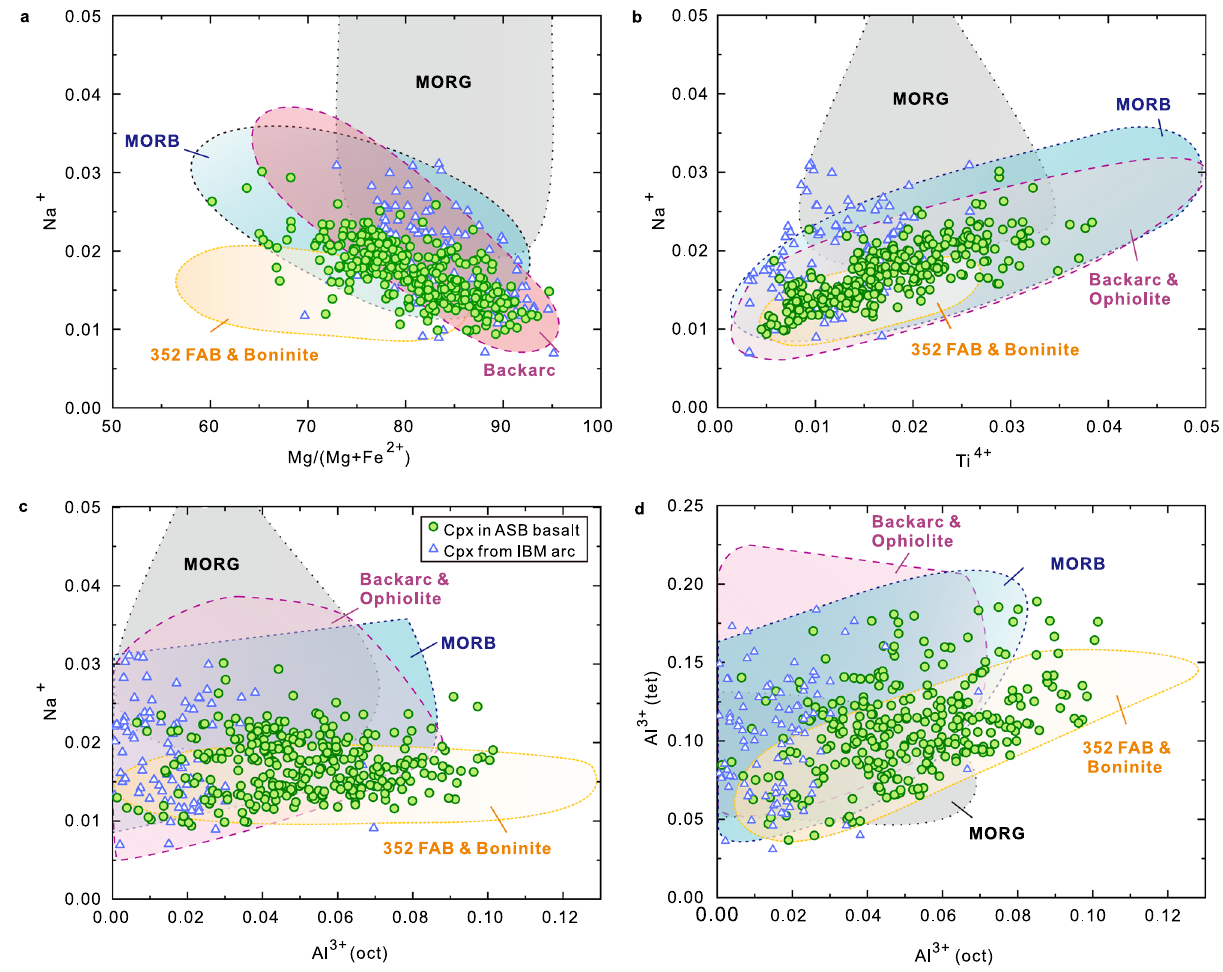
Fig. 3 Clinopyroxene compositions in 351 Unit 1 of ASB basalt (green circles) compared with 351 Unit IV (blue triangles) recording the nascent IBM arc 35 immediately overlying the ASB basalt, mid-ocean ridge basalt and gabbro (MORB/G), 352 FAB and boninite 36 , Oman ophiolite 37 and backarcs (Data from PetDatabase website). Consistently coloured shading and lettering are used for these speci fi ed compositional fi elds. a Na + versus 100 ∗ Mg/ (Mg + Fe 2 + ) for clinopyroxene in Unit 1 ASB basalt and Unit IV recording the nascent IBM arc 35 , showing compositional overlap compared with clinopyroxene in MORB/G and backarcs, but a contrasted trend compared with FAB and boninite; b Na + versus Ti 4 + . c Na + versus octahedrally coordinated Al 3 + . d Tetrahedrally coordinated versus octahedrally coordinated Al 3 + (Al 3 + (tet) and Al 3 + (oct) respectively). All cations calculated on the basis of 6 oxygen anions. References for data sources used for clinopyroxene in MORB/G are in the Supplementary Material. Oman ophiolite and backarc data mostly overlap, scatter plots are in Supplementary Fig.